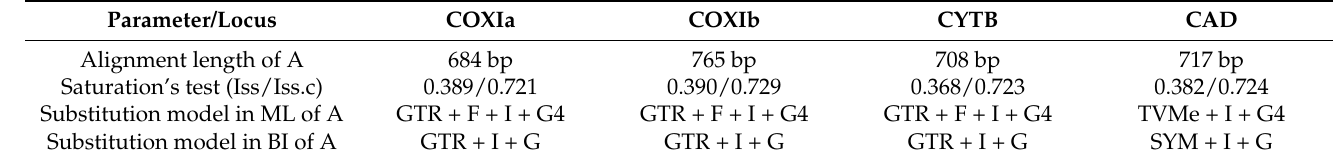
Table 2. The loci information, substitution saturation analysis and partitioning scheme for the dataset based on the genes of a basic tree and the respective best models. A: phylogenetic tree for muscoids. Parameter/Locus COXIa COXIb CYTB CAD Alignment length of A 684 bp 765 bp 708 bp 717 bp Saturation’s test